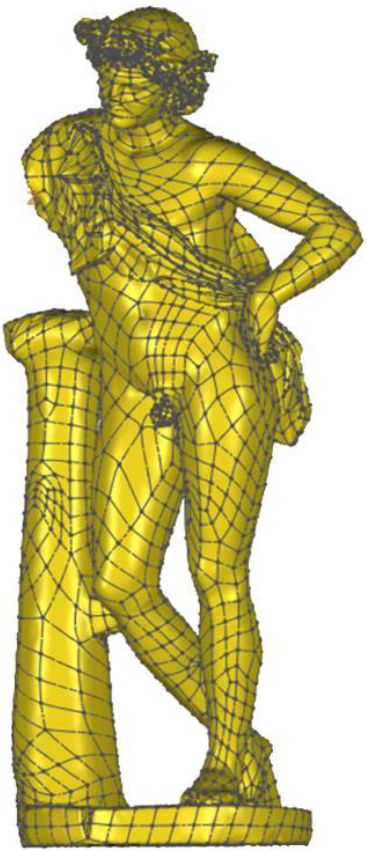
Figure 19. Solid model of the Resting Satyr .